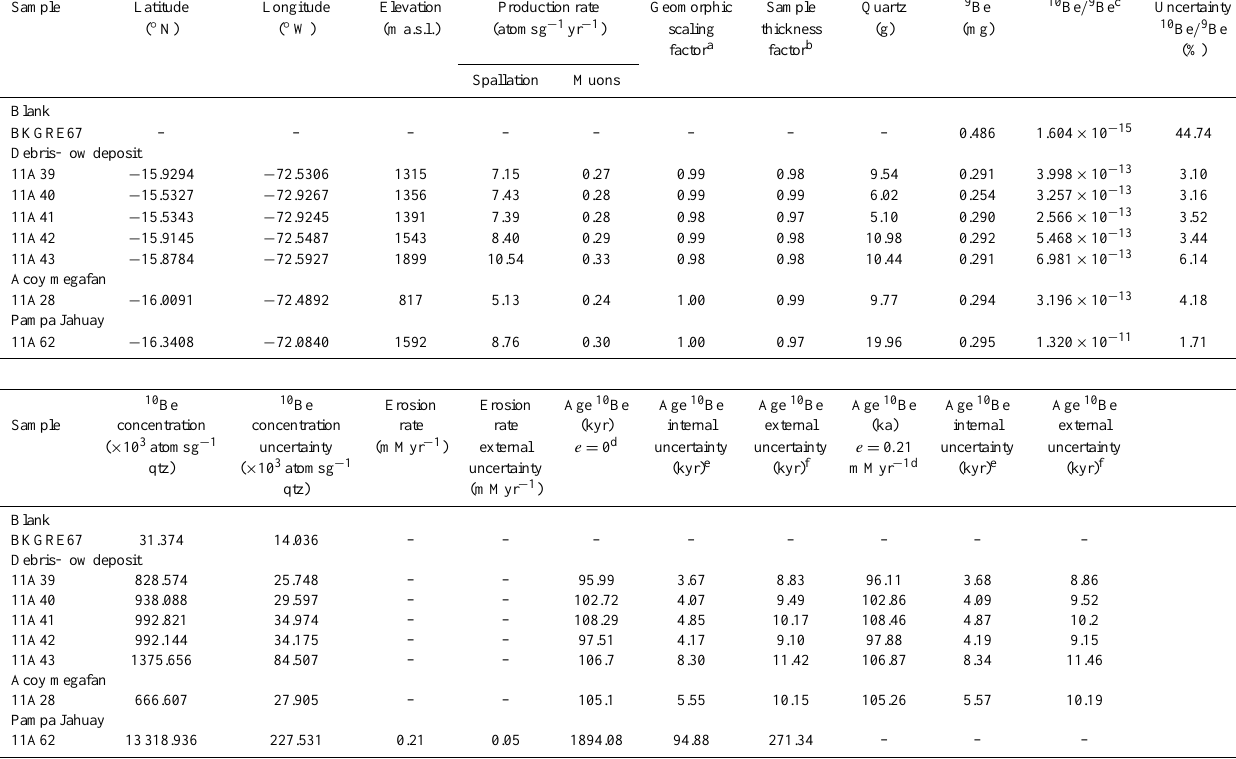
Table 1. TCN results of the Chuquibamba Valley and the Pampa Jahuay.